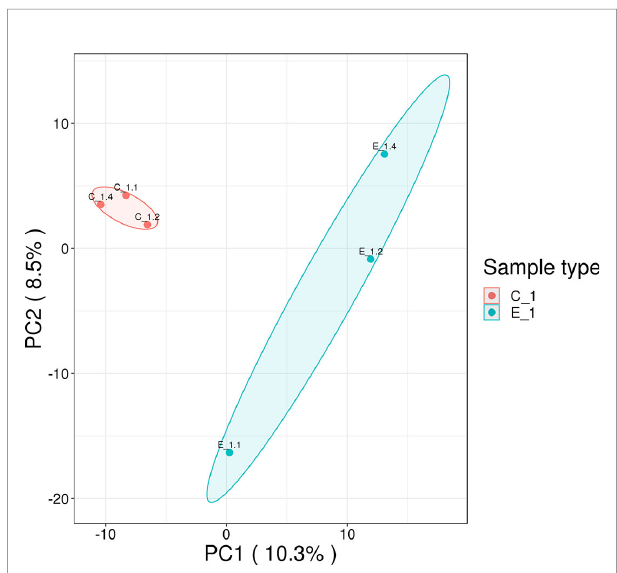
FIGURE 2 | Principal component analysis of proteomics data. The distance of each sample point represents the degree of similarity between samples. The closer the sample points, the higher the similarity between